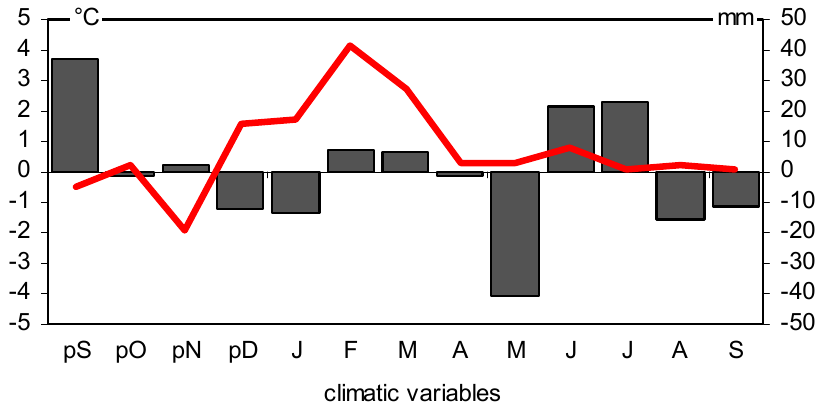
Figure 11. The climatic diagram. Differences in mean monthly temperature (red line) and precipita- tion (black bars) between the negative and positive pointer